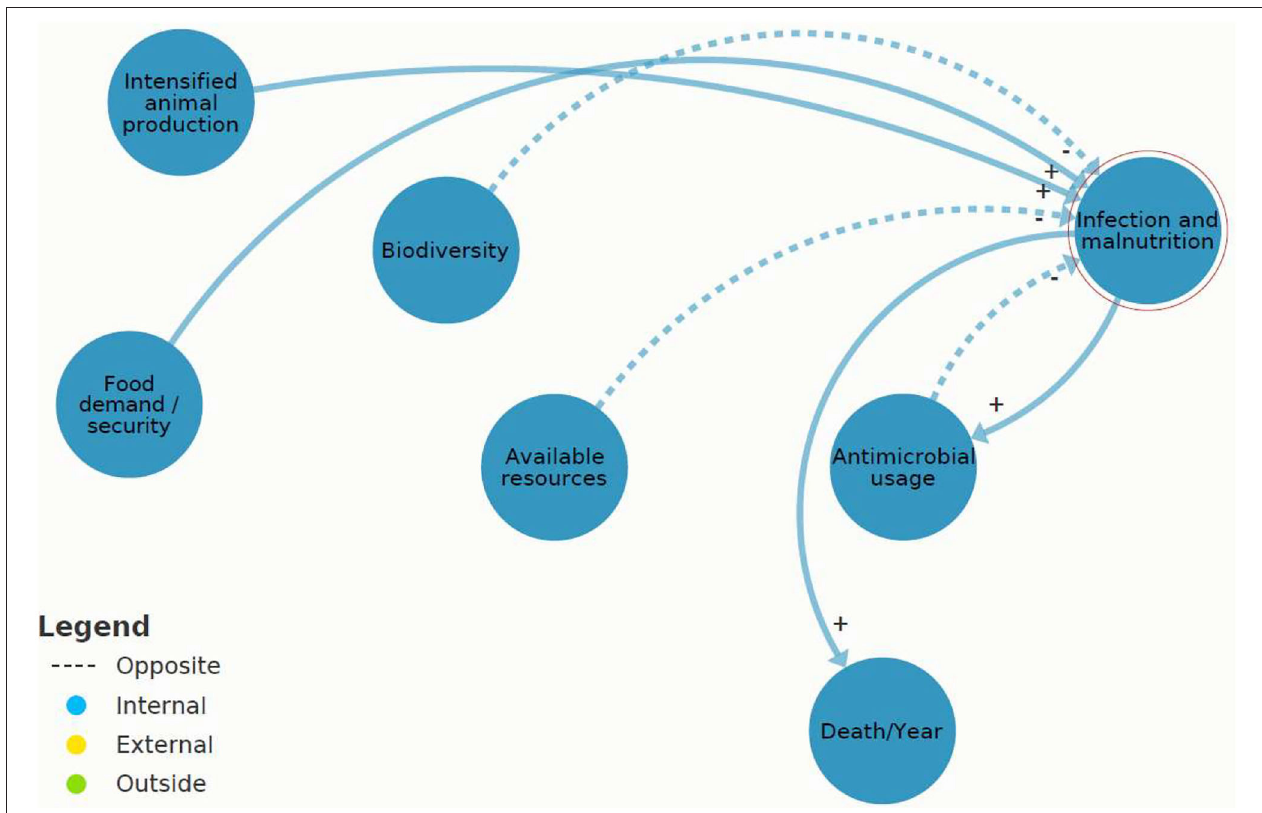
FIGURE 6 | A section of Figure 3 : causal loops in present antimicrobial resistance (AMR) map of “infection and malnutrition” (IM) created (2021) in Kumu.io.